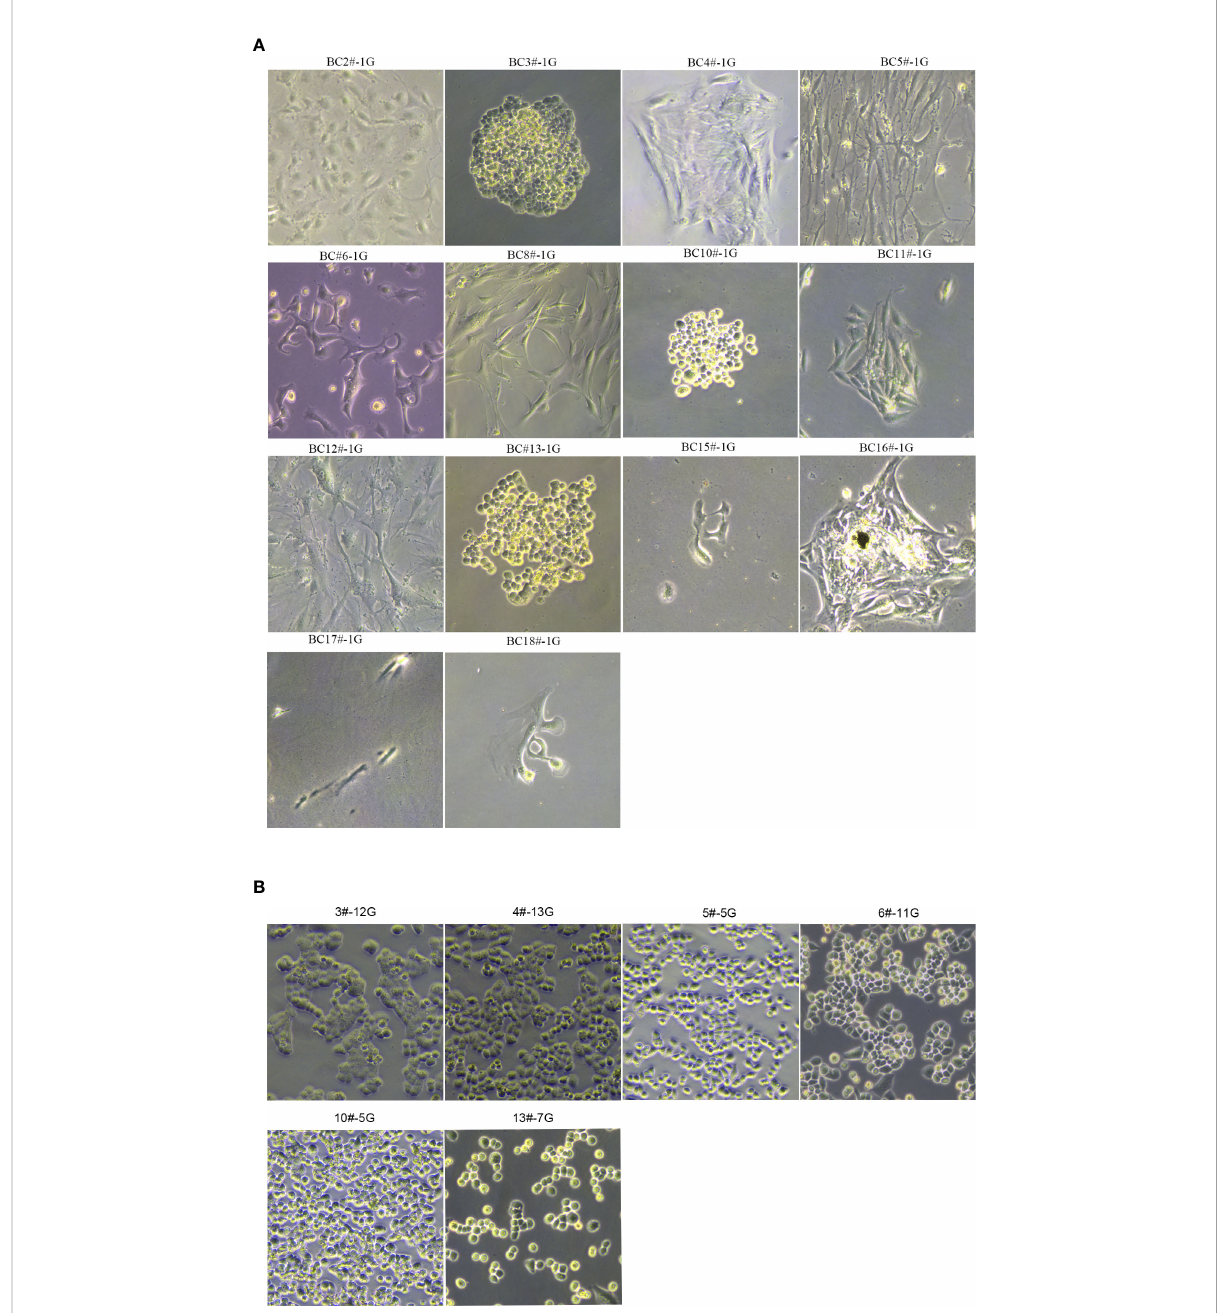
FIGURE 1 The morphology of primary breast cancer cells. (A) BC2#-1G, BC3#-1G, BC4#-1G, BC5#-1G, BC6#-1G, BC8#-1G, BC10#-1G, BC11#-1G, BC12#-1G, BC13#-1G, BC15#-1G, BC16#-1G, BC17#-1G and BC18#-1G. (B) The morphology of primary breast cancer cells: BC3#-12G, BC4#-13G, BC5#-5G, BC6#-11G, BC10#-5G, and BC13#-7G (magni fi cation Number ×100). # means patient. G means